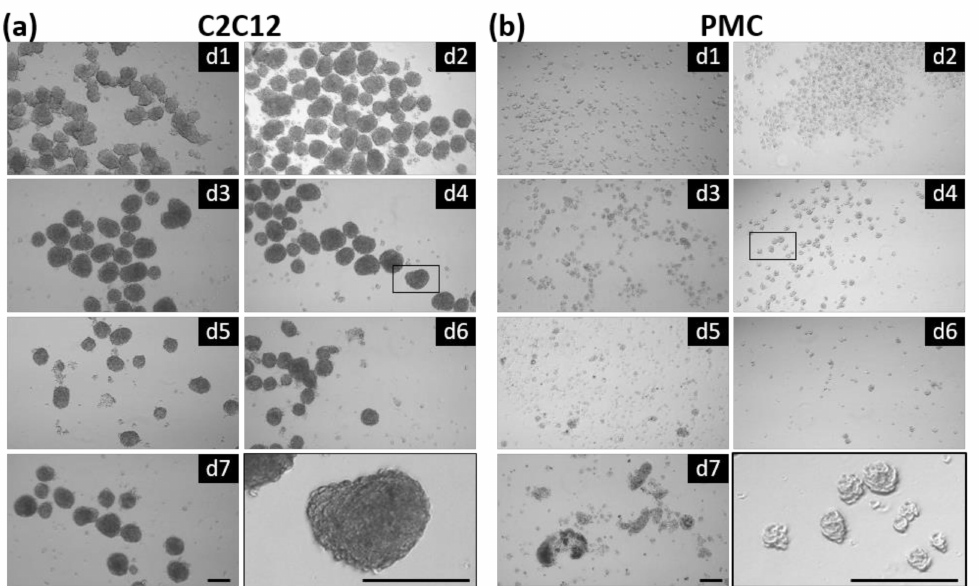
Figure 1. Myosphere formation in suspension culture. C2C12 ( a ) and primary pig muscle cells (PMCs, ( b )) were seeded (200,000 or 100,000 cells/mL, respectively) into the CERO 3D Incubator and Bioreactor (OLS) and spheroid formation was analyzed for 7 days. A considerable number of round-shaped spheroids was seen at all time points. The image on the bottom (right side) shows a magnification of spheroid(s) at Day 4. Scale bar: 200 µ